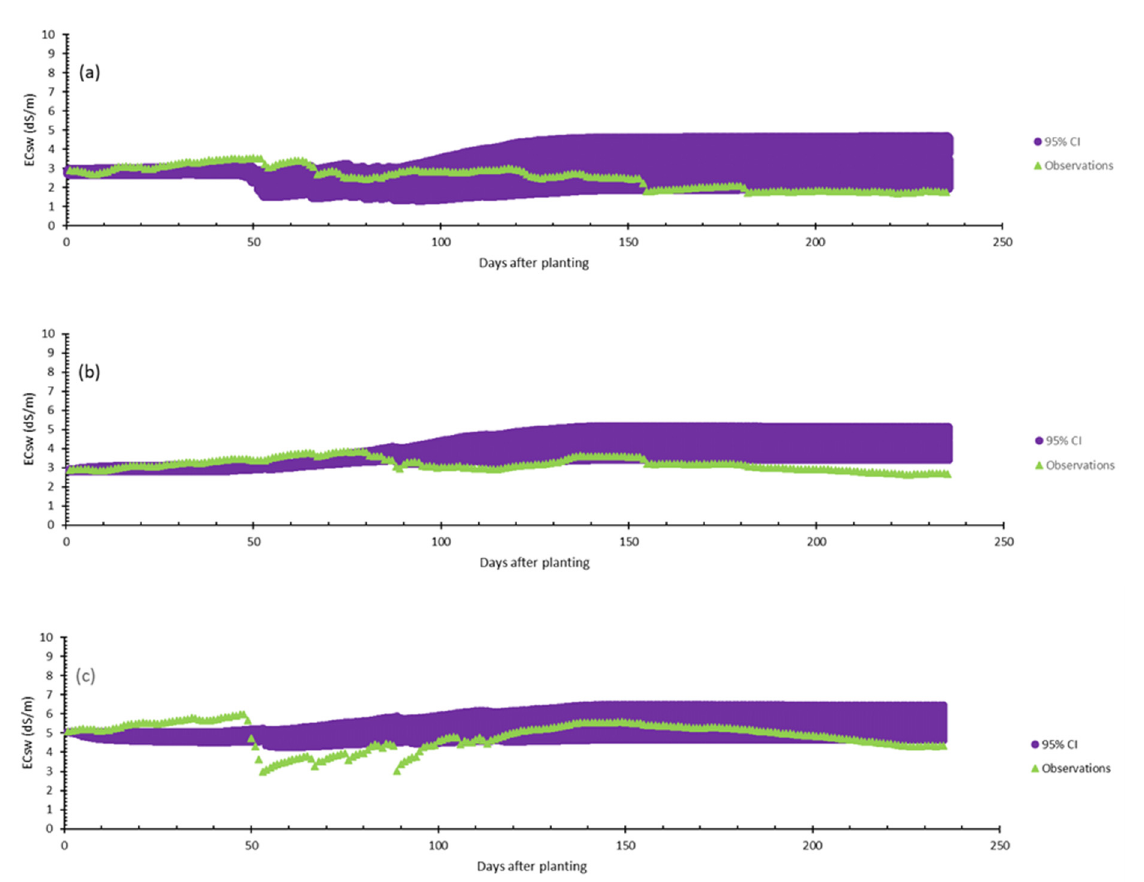
Figure 6. Predictive uncertainty of the HYDRUS-1D mode for simulating soil salinity of corn root zone at ( a ) 16, ( b ) 46 and ( c ) 76 cm